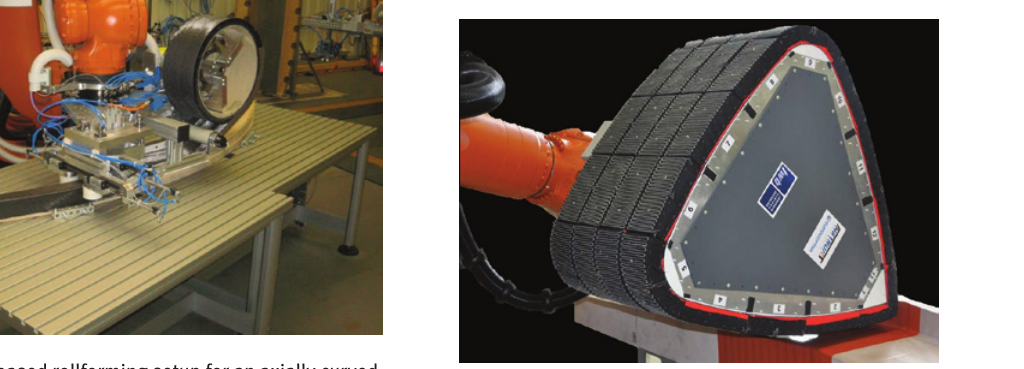
Figure 11: Processing head for the Pick&Drape technology. Source: Airbus